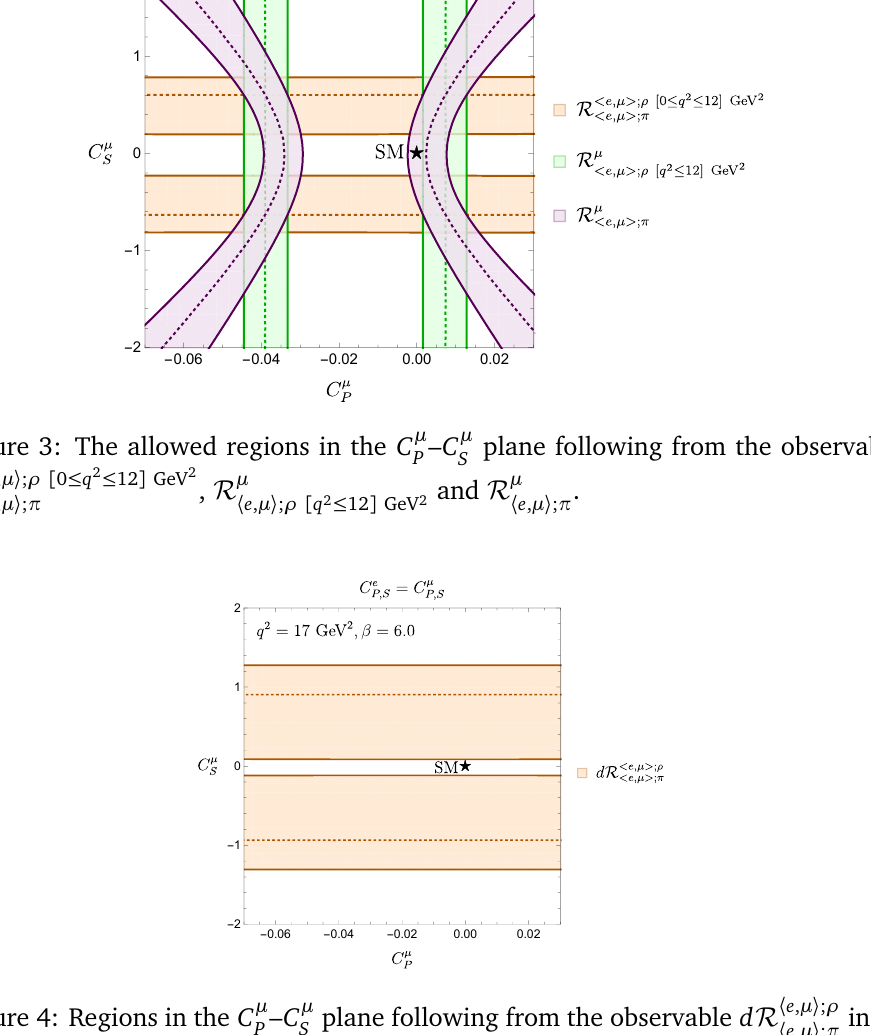
Figure 4: Regions in the C large q 2 regime for q 2 = 17 GeV 2